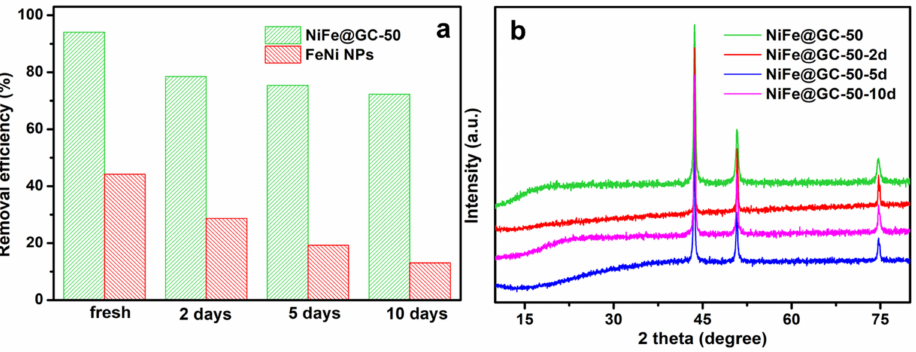
Figure 4. ( a ) Effects of aging time on the removal efficiency, ( b ) XRD patterns of aged NiFe@GC-50. (Experimental conditions: TCP = 30 mg L − 1 , pH = 3.0, dosage = 1.0 g L − 1 , T = 298.15